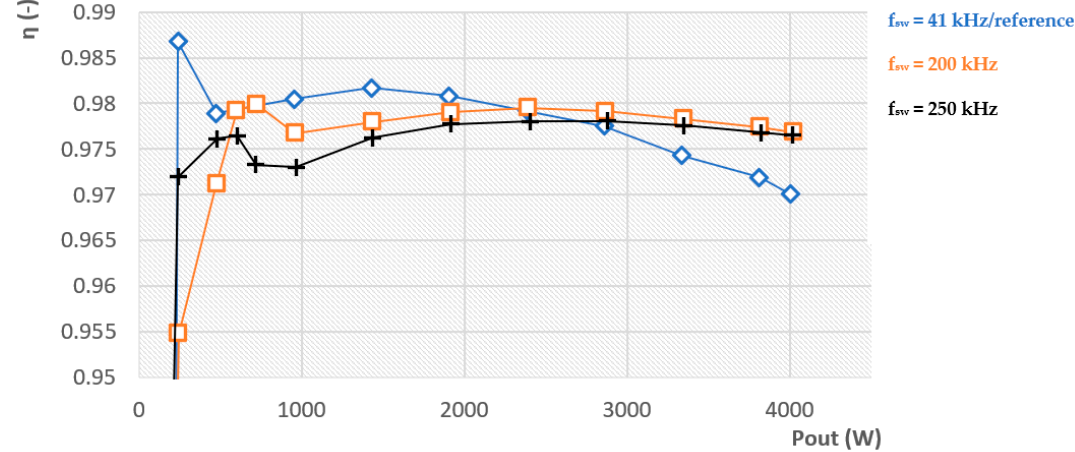
Figure 16. Efficiency characteristic of PFC converter equipped with IGT60R070D1 GaN transistor in dependency on the output power and switching frequency (blue line—referenced non-optimized solution).